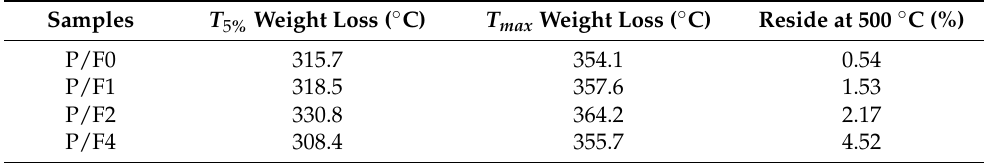
Table 4. TGA data of P/F